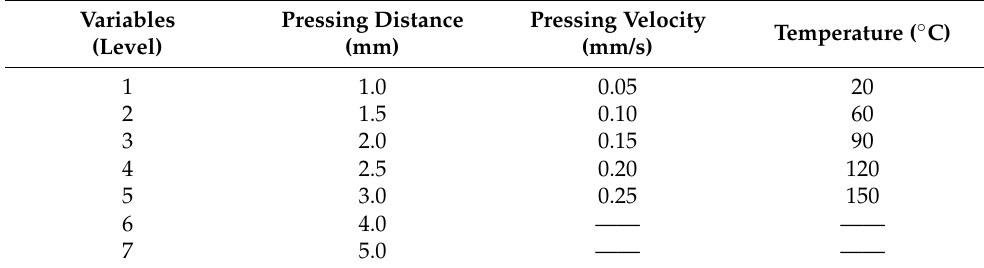
Table 1. Factors and levels of compression